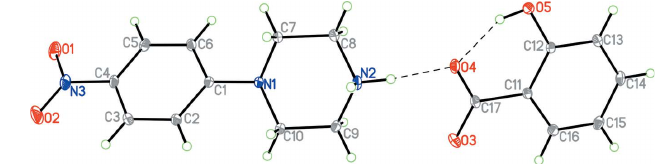
Figure 1 Diagram showing atom labelling and the arrangement of cation and anion in 1 . Hydrogen bonds are shown by dashed lines. Atomic displacement parameters are at the 30% probability level.